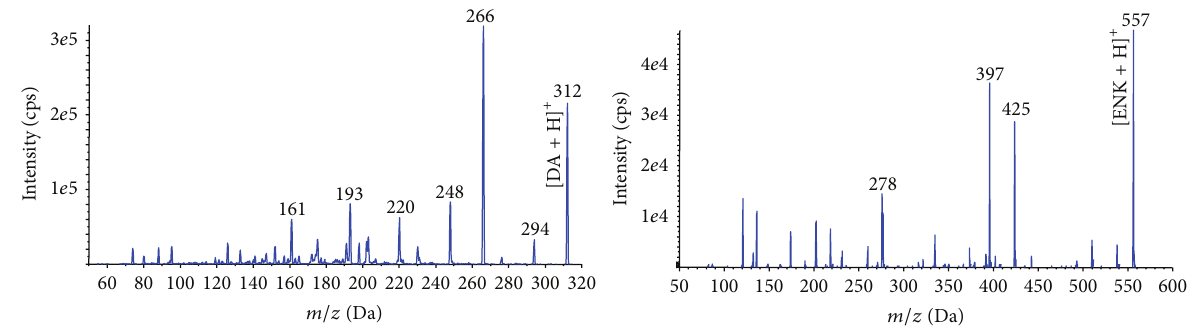
Figure 2: Product ion MS/MS spectra of DA and internal standard ENK in positive ion mode, using a collision energy of 10eV.